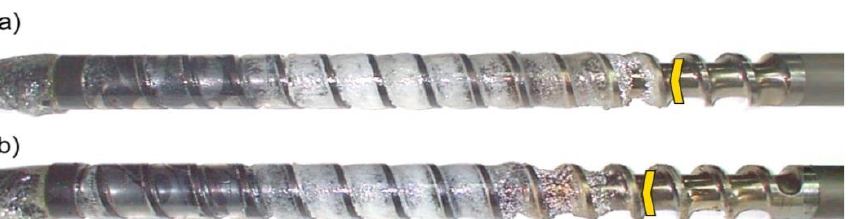
Figure 14. An effect of the plastication stroke on the polymer flow in the injection molding process at the screw speed N = 300 rpm, and the back pressure P back = 2 MPa: ( a ) h plast = 1 D, ( b ) h plast = 3 D.